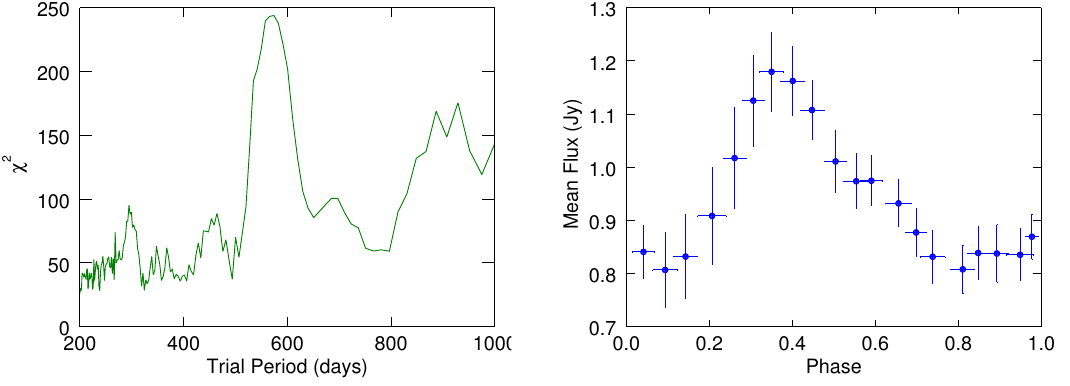
Figure 2. Epoch-folding of the radio light curve of blazar J1043+2408. Left panel : χ 2 values for the trial periods between 200 and 1000 days. Right panel : pulse profile of the periodic component at the timescale of 563 days representing maximum χ 2